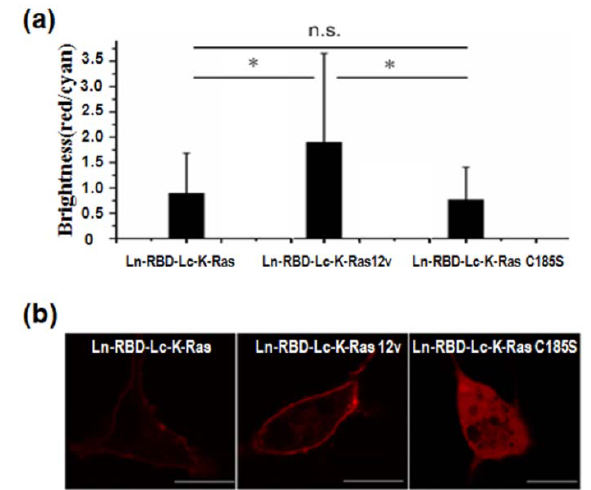
Figure 2. BiFC assays of interaction between K-Ras and RBD. ( a ) BiFC efficiency analysis and ( b ) confocal imaging of cells cotransfected with pBud-Ln-Grb2-Lc-K-Ras (K-Ras 12v or K-Ras C185S) and pmCerulean-C1. Scale bar = 20 μ